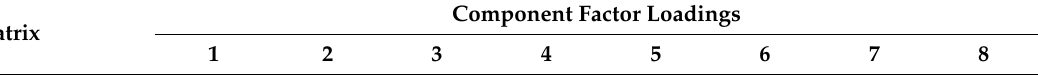
Table 6. NPmot.pt exploratory factorial analysis (structure matrix; n =